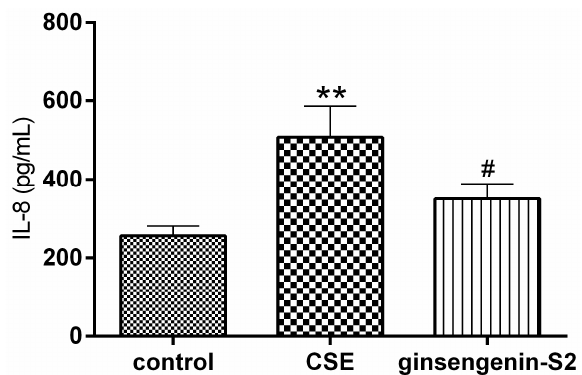
Figure 6. Anti-inflammatory effect of ginsengenin-S2 (100 µ M) on the inflammatory cytokine interleukin-8 (IL-8) in CS-exposed A549 cells. All data were expressed as mean ± S.D., n = 4. ** p < 0.01, compared with control; # p < 0.05, compared with the CSE